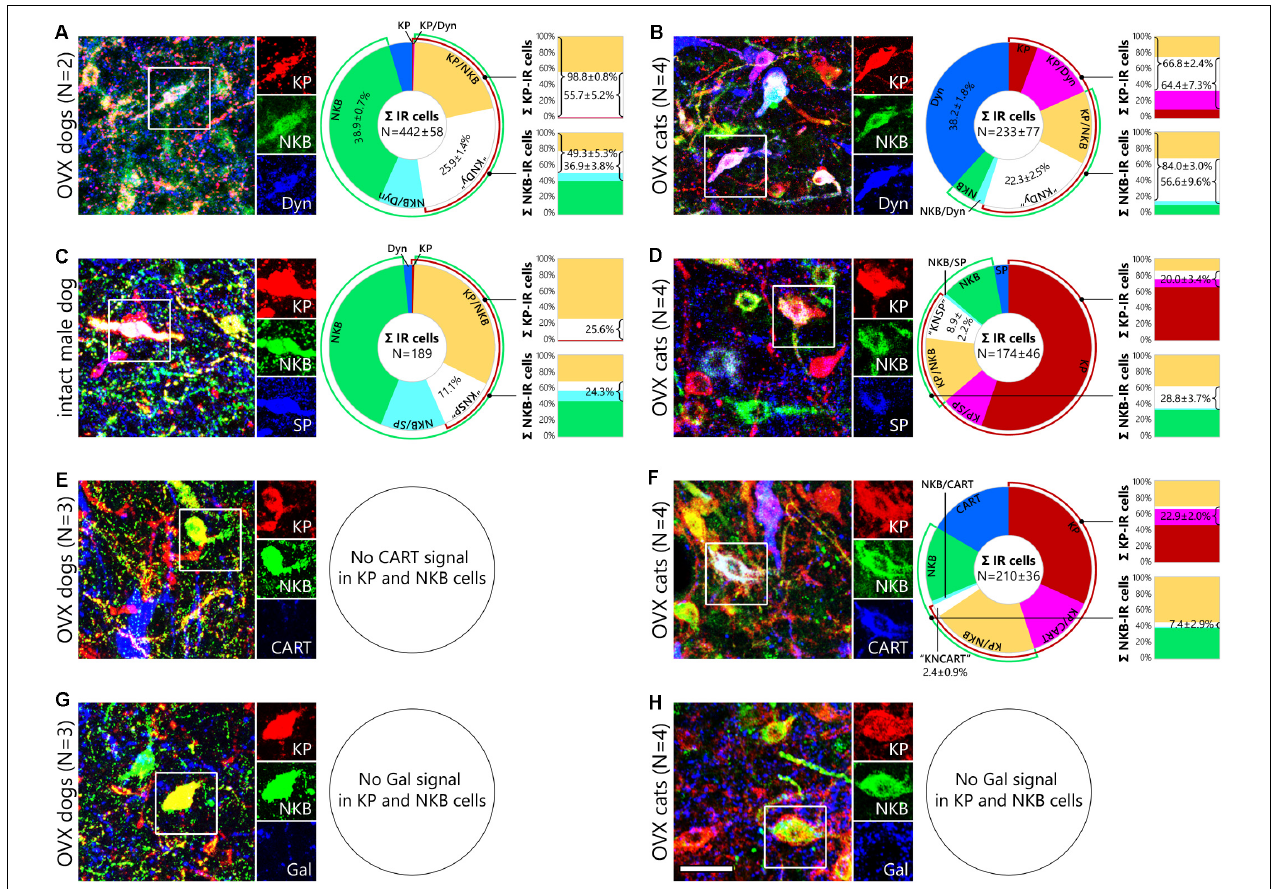
FIGURE 2 | Neurochemistry of canine and feline kisspeptin and neurokinin B cells. Representative photomicrographs illustrate the neuropeptide phenotype of canine and feline kisspeptin (KP; red) and neurokinin B (NKB; green) neurons. Cells framed in the three-color figures are shown in separate color channels on the right side of each panel. KP and NKB immunoreactivities overlap considerably but incompletely in the infundibular nucleus of dogs (A,C,E,G) and ovariectomized (OVX) cats (B,D,F,H) . Pie charts illustrate the percent distribution of distinct neuronal phenotypes from triple-immunofluorescence experiments addressing dynorphin (Dyn; A ), substance P (SP; B ) and cocaine- and amphetamine-regulated transcript (CART; C ) co-expression in KP and NKB neurons. Bar graphs show percentages of neuropeptide colocalization in KP neurons (upper columns) and NKB neurons (bottom columns). Dynorphin signal (blue) occurs in large subsets of canine (A) and feline (B) KP and NKB cells; ∼ 25% of the immunolabeled infundibular neurons are triple-labeled (“KNDy”) cells in both dogs and cats. Substance P (blue) is detectable in 26% of KP and 24% of NKB neurons in an intact male dog (C) as well as in 20% of KP and 29% of NKB cells in OVX cats (D) . CART (blue) is also present in 23% of KP and 7% of NKB neurons in OVX cats (F) , but no CART signal is detectable in canine KP and NKB cells (E) . Galanin is not expressed in KP and NKB neurons of either species ( G,H ). CART, cocaine- and amphetamine regulated transcript; Dyn, dynorphin; Gal, galanin; KP, kisspeptin; “KNCART”, kisspeptin/neurokinin B/ cocaine- and amphetamine regulated transcript-positive cells; “KNDy”, kisspeptin/neurokinin B/dynorphin-positive cells; “KNSP”, kisspeptin/neurokinin B/substance P-positive cells; NKB, neurokinin B; SP, substance P. Scale bar: 50 µ